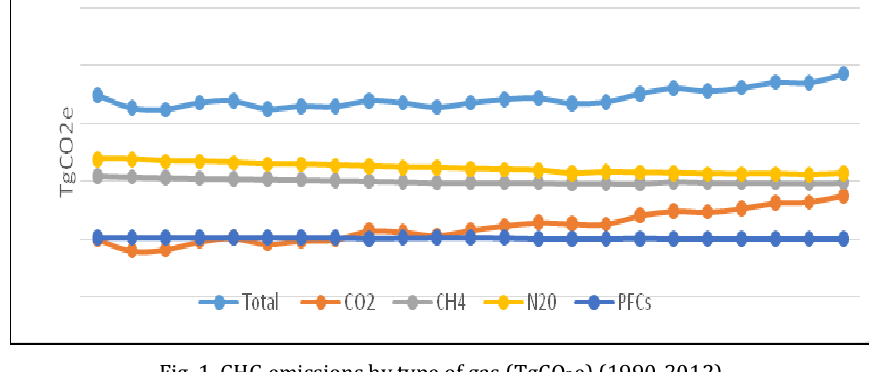
Fig. 1. GHG emissions by type of gas (TgCO 2 e) (1990-2012) (source: Climate Change Unit, Environmental Protection Agency, Ghana, 2014)